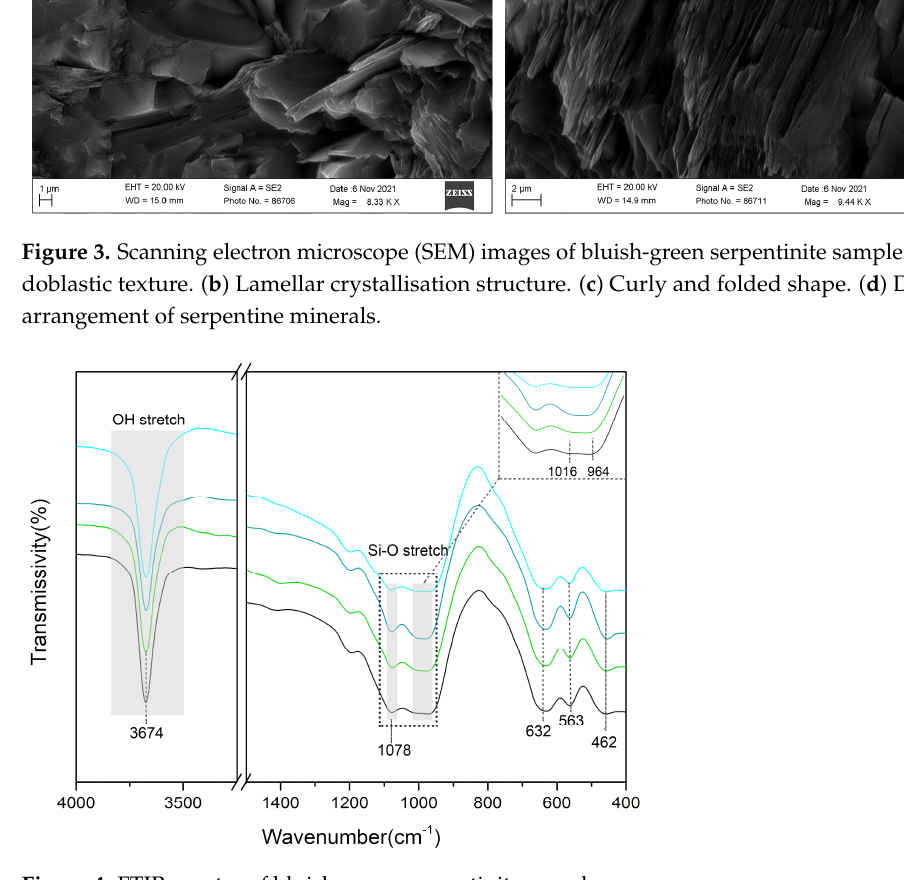
Figure 4. FTIR spectra of bluish-green serpentinite samples.